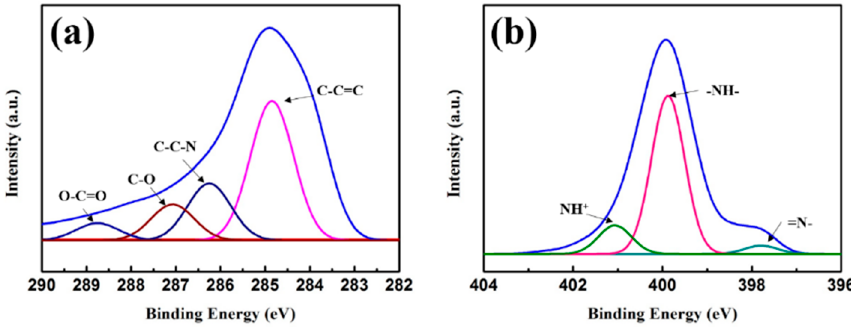
Figure 1. XRD patterns of pristine CuS and Sample B.